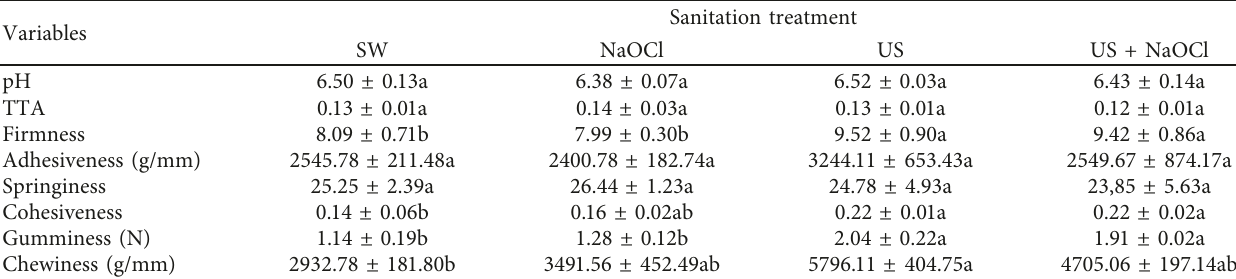
Table 1: Mean values of texture profile analysis and physicochemical parameters of melon. Variables